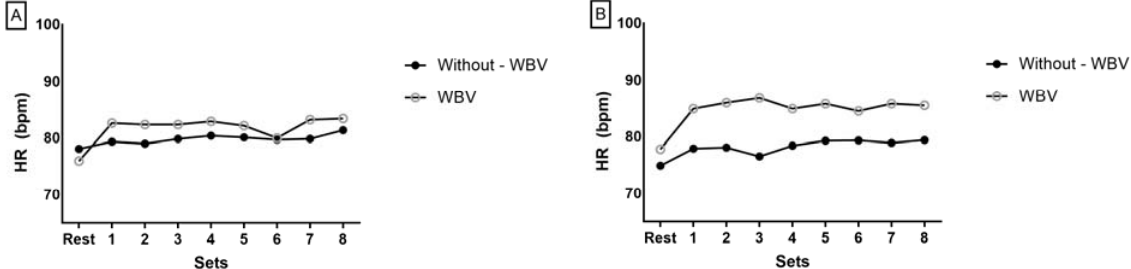
Figure 3. Heart rate (HR) behavior after each set of exercises in situations with and without whole-body vibration in the nonsarcopenic ( A ) and sarcopenic ( B ) groups.